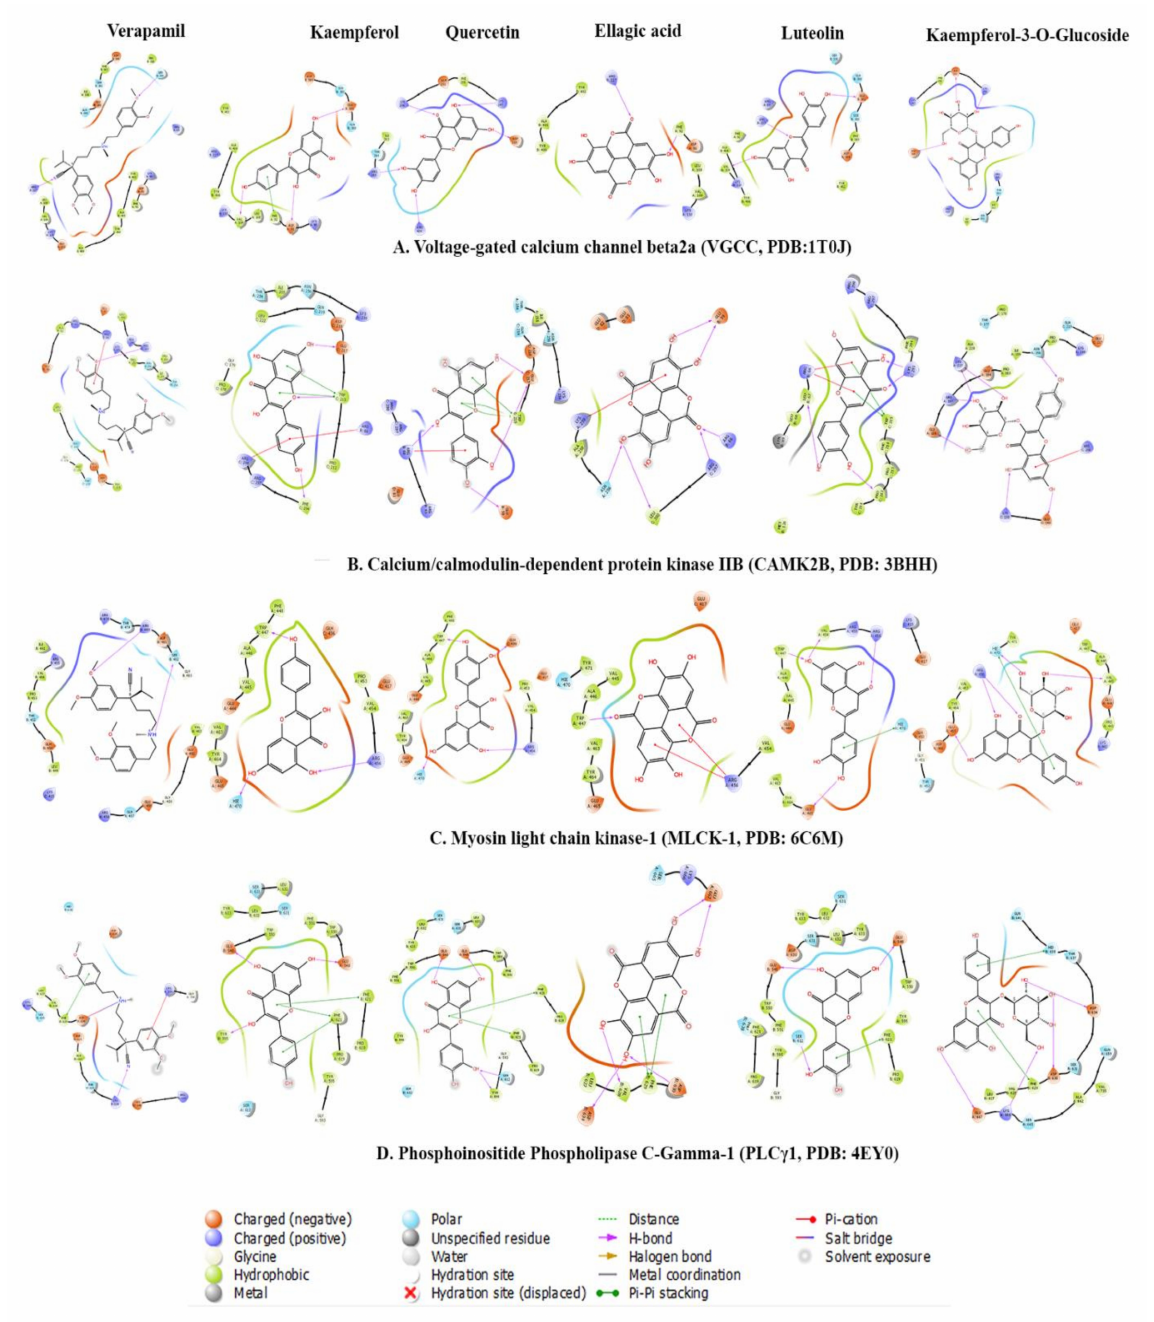
Figure 7. 2D protein–ligand interaction between bioactive compounds (verapamil, kaempferol, quercetin, ellagic acid, luteolin and kaempferol-3- O -glucoside) and proteins; ( A ) voltage-gated calcium channel β 2a (VGCC, PDB:1T0J); ( B ) calcium/calmodulin-dependent protein kinase IIB (CAMK2B, PDB: 3BHH); ( C ) myosin light chain kinase-1 (MLCK-1, PDB:6C6M); and ( D ) phosphoinositide phospholipase C-gamma-1 (PLC γ -1, PDB: